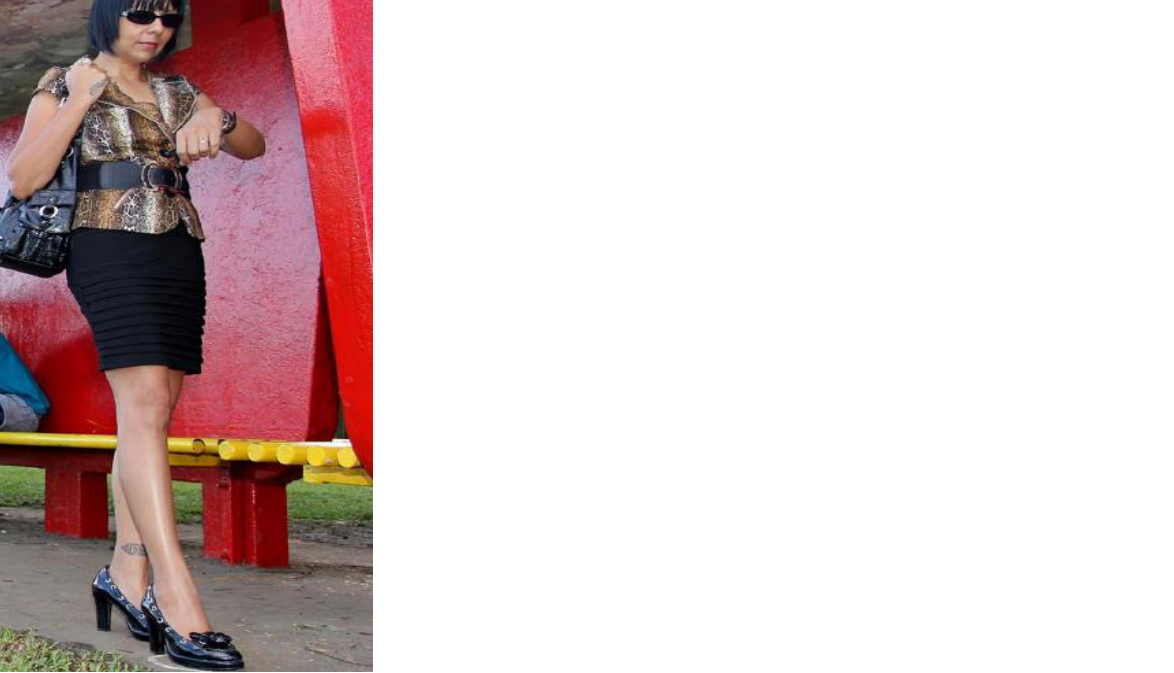
SCENARIO 5: Female socialising outside the home; women’s capacity to safely move independently in the community